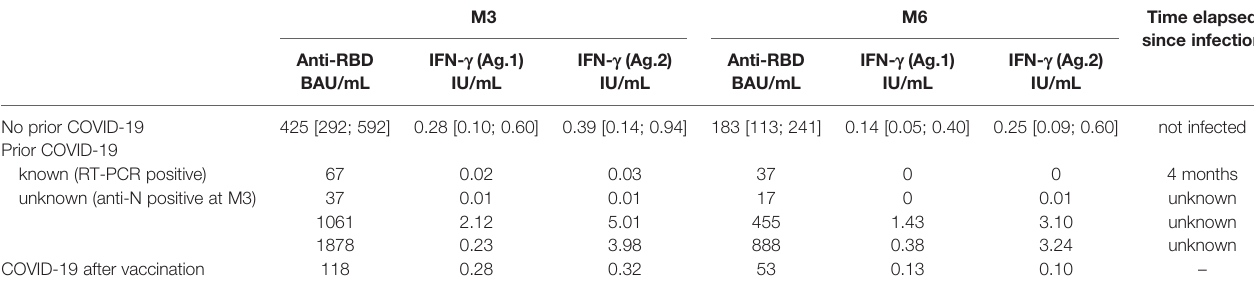
TABLE 3 | Anti-RBD IgG and IFN- g titres 3 and 6 months after vaccination in healthcare workers according to prior infection or